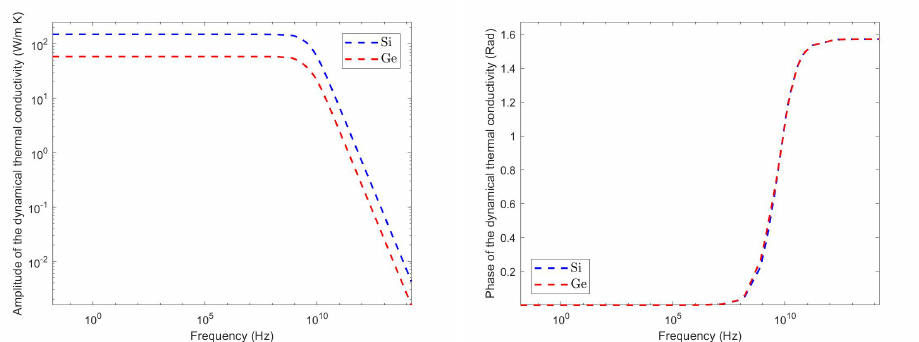
Figure 4. ( Left ): Amplitude of the dynamical thermal conductivity vs. frequency. ( Right ): Phase of the dynamical thermal conductivity vs. frequency. T = 300